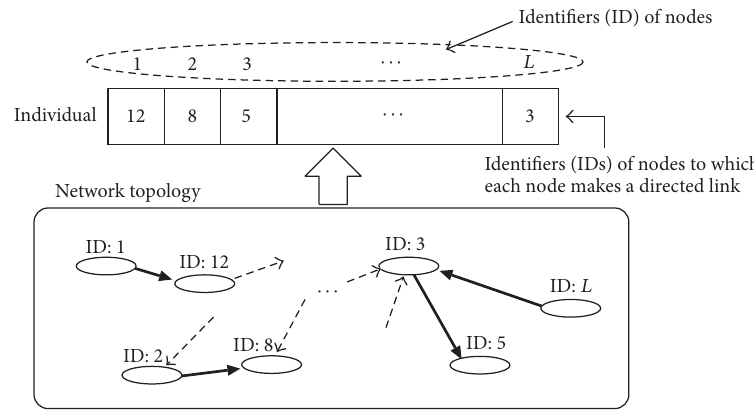
Figure 2: Representation of a P2P network topology in the EA (EA individual) when 𝑁 𝐶 = 1